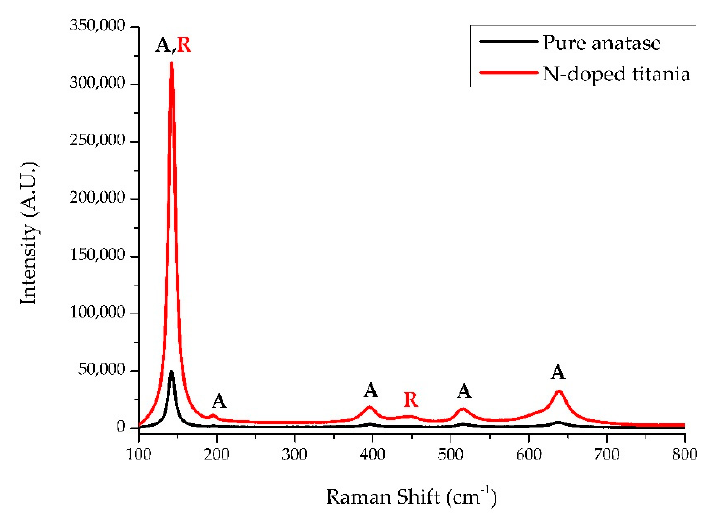
Figure 2. Raman spectra of N-doped TiO 2 powder and pure anatase.